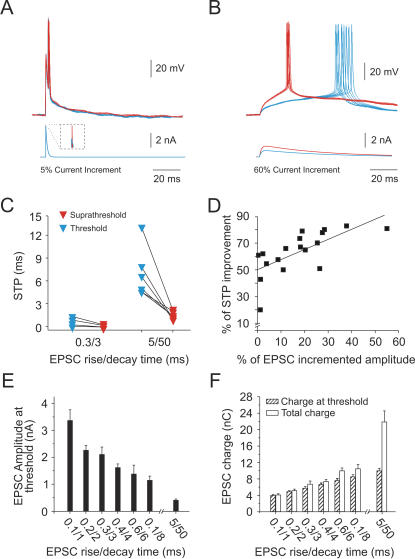
Increasing compound EPSC amplitude increases STP. For both fast and slow compound EPSCs increasing the amplitude improved STP. However, slow compounds required an ∼40% increase in amplitude to improve STP by 50%, whereas only ∼5% amplitude increase was required to achieve the same improvement with fast compound EPSCs. A,B, Action potential responses induced by compound EPSCs at threshold (blue) and suprathreshold (red) level. For each case in A,B, 10 raw data traces are shown superimposed. A, Action potentials induced by a compound EPSC of τrise/τdecay 0.3/3 ms. Red traces are responses to stimuli with a 5% current increment above threshold level; inset shows a zoom of the tip of the trace. B, Spike responses induced by a compound EPSC of τrise/τdecay 5/50 ms. Red traces were induced by 60% current increment stimulation over the threshold level. C, STP as a function of two compound EPSCs before and after increasing the compound amplitude above the initial threshold value. Each connected pair of triangles represents one cell. D, The percentage of improvement of STP was linearly related to the degree of EPSC amplitude increment, independently of EPSC shape (r = .68, p = .001). Measurements were made with EPSCs of τrise/τdecay 0.3/3, 0.6/6 5/50, 5/83, 5/200 ms. E, The current peak amplitude at spike threshold for EPSCs with different kinetics. F, The total charge (open bars) and charge at spike threshold (filled bars) for EPSCs with different kinetics. High peak currents for fast EPSPs are partially due to the charging of the membrane capacitance. Charge was measured as the integral of the compound EPSC area (mean±s.e.m.; n = 10 cells).